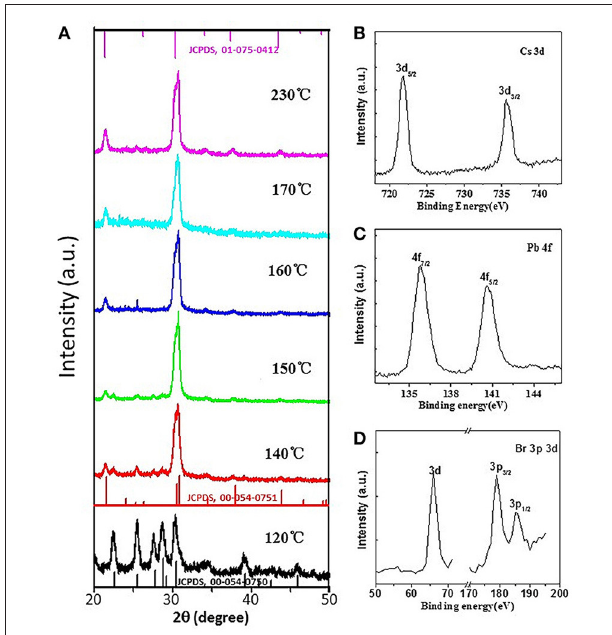
FIGURE 2 | (A) XRD patterns of as-synthesized perovskite CsPbBr 3 QDs formed at different temperatures, (B–D) high-resolution XPS spectra of perovskite CsPbBr 3 QDs formed at 150 ◦ C.